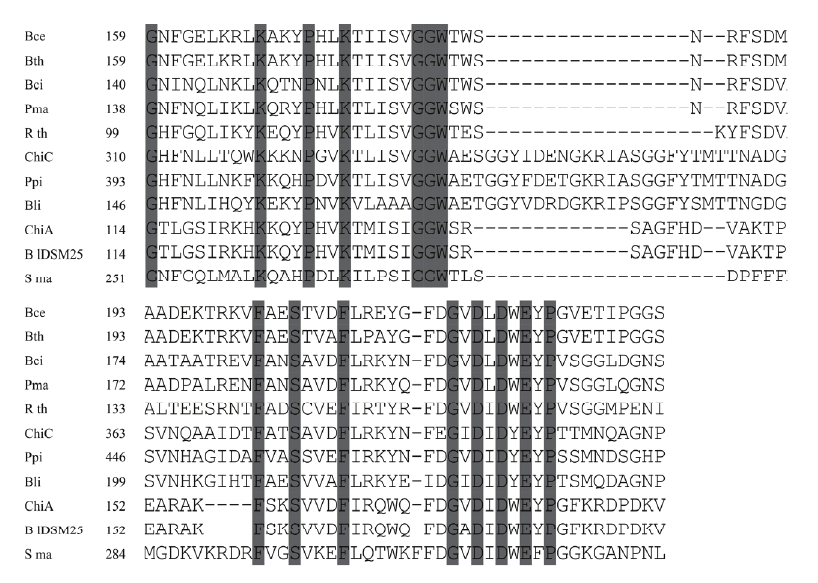
Figure 2. Alignment of the catalytic region from ChiA and ChiC with chitinases from B. cereus (Bce, EEK85987.1), B. thuringiensis (Bth, EEM24441.1), B. circulans (Bci, AAA81528.1), P. macerans (Pma, KFM93118.1), R. thermocellum (Rth, CAA93150.1), Pseudoalteromonas piscicidagi (Ppi, BAB79618.1), B. licheniformis (Bli, ACI24006.1), B. laterosporus DSM25 (BlDSM25, WP_003336146.1) and S. marcescens (Sma,